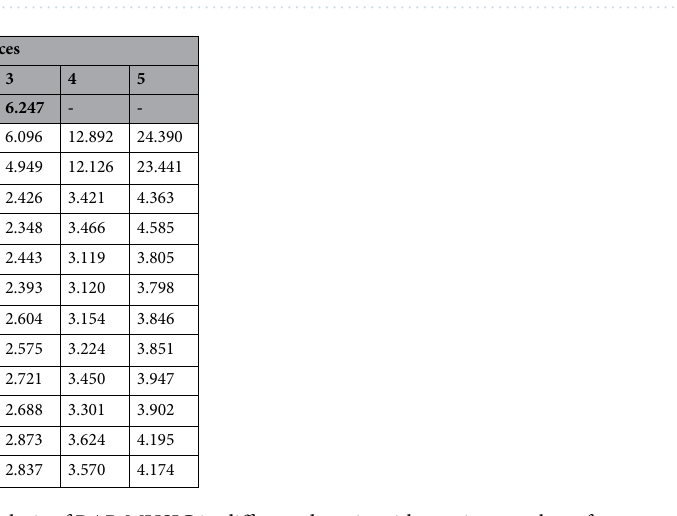
2 Figure 5. Performance of Spatial, SH and H based MUSIC, RAP-MUSIC for two concurrent active sources at 5 dB SNR, ( a ) Localization error with varying array order N a ( b ) Localization error with varying inter source correlation ( c ) Computation time with varying array order N a .